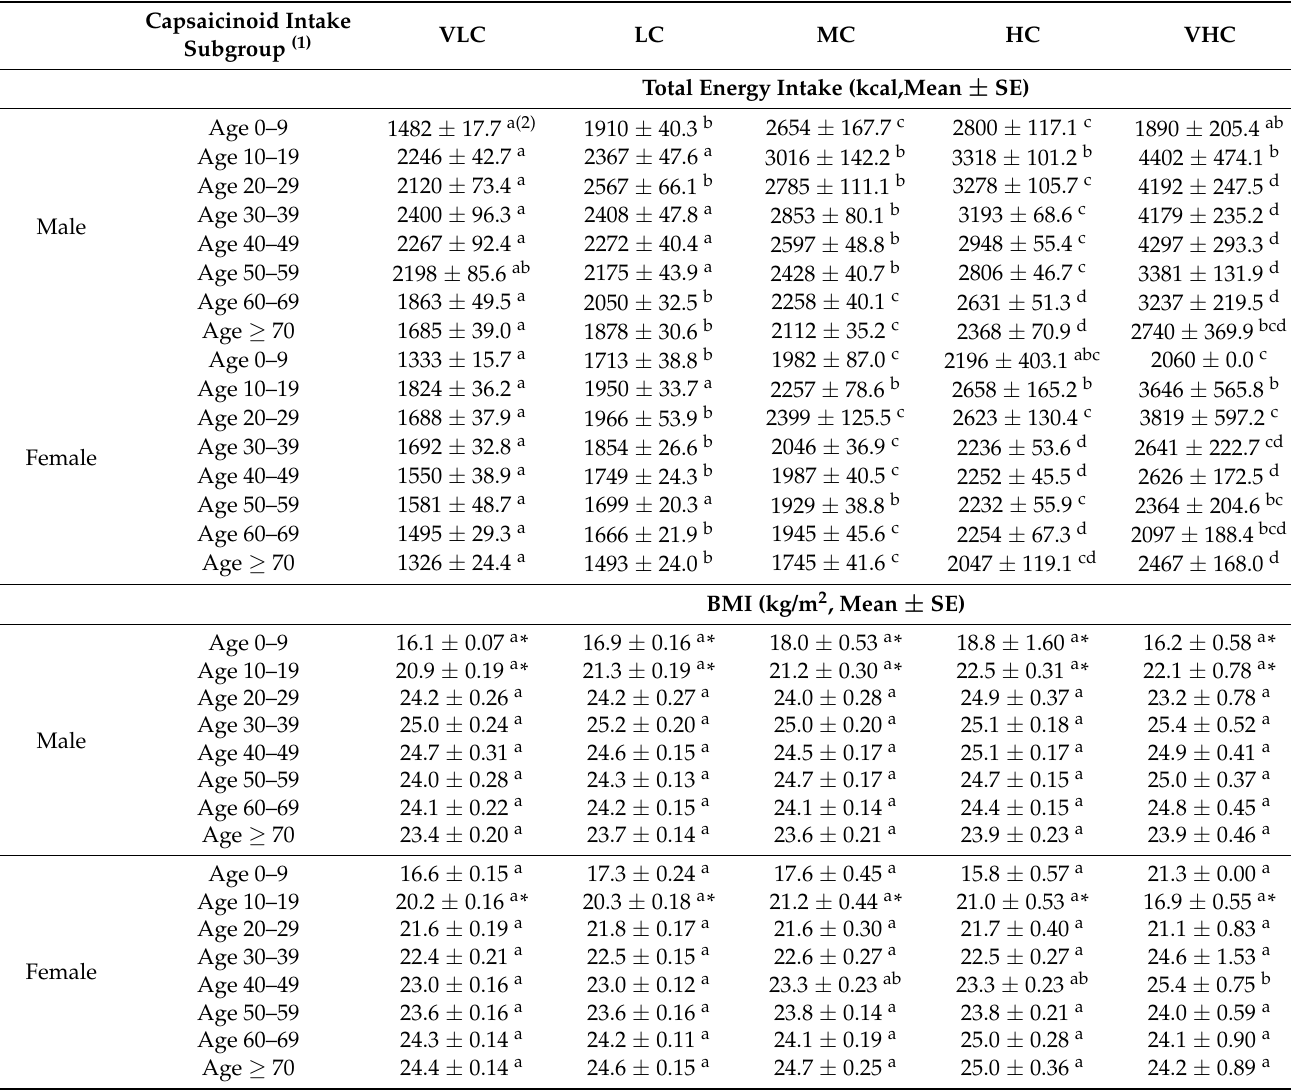
Table 4. Total energy intake and BMI in the five capsaicinoid intake subgroups in each age and sex group. Capsaicinoid